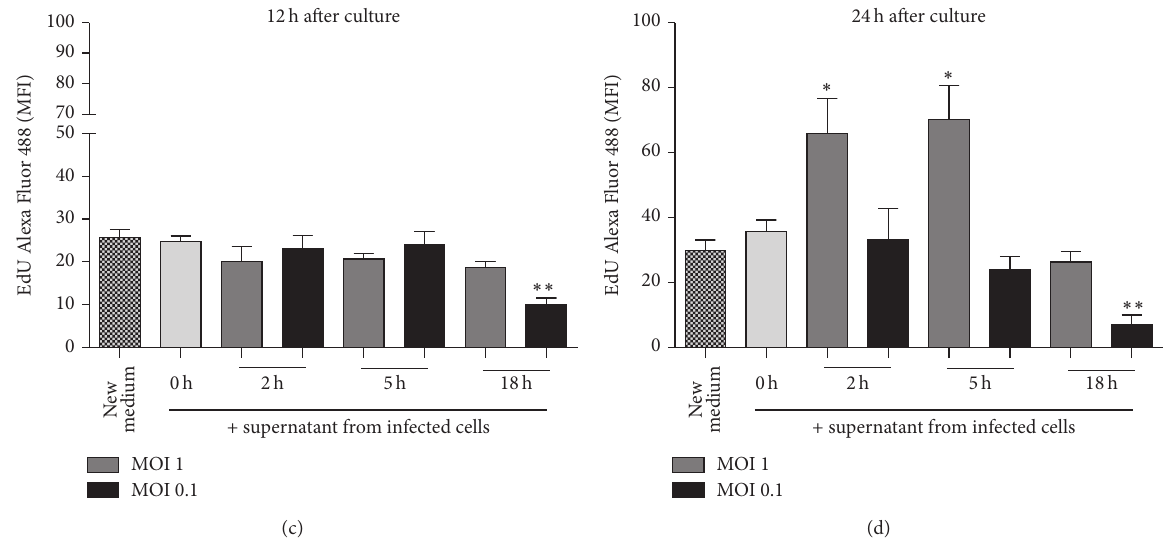
Figure 5: Microenvironment produced by BCG infection at MOI 1 affects macrophage proliferation. (a) and (b) Representative histograms measuring mean fluorescence intensity (MFI) of Alexa Fluor 488 after 12h and 24 h. (c) and (d) Supernatant from infected cells was recovered at different time points after infection and added to fresh RAW macrophages and proliferation was evaluated at 12 h and 24 h in the presence of EdU. RAW macrophages were stained with Alexa Fluor 488 and proliferation was evaluated by flow cytometry. Two-tailed unpaired Student’s 𝑡 -test was used to evaluate differences versus macrophages proliferation in new medium. Bars indicate mean ± SEM from three independent experiments. ∗∗ 𝑃 < 0.01 ; ∗ 𝑃 < 0.05 . The light grey bar refers to uninfected cells or